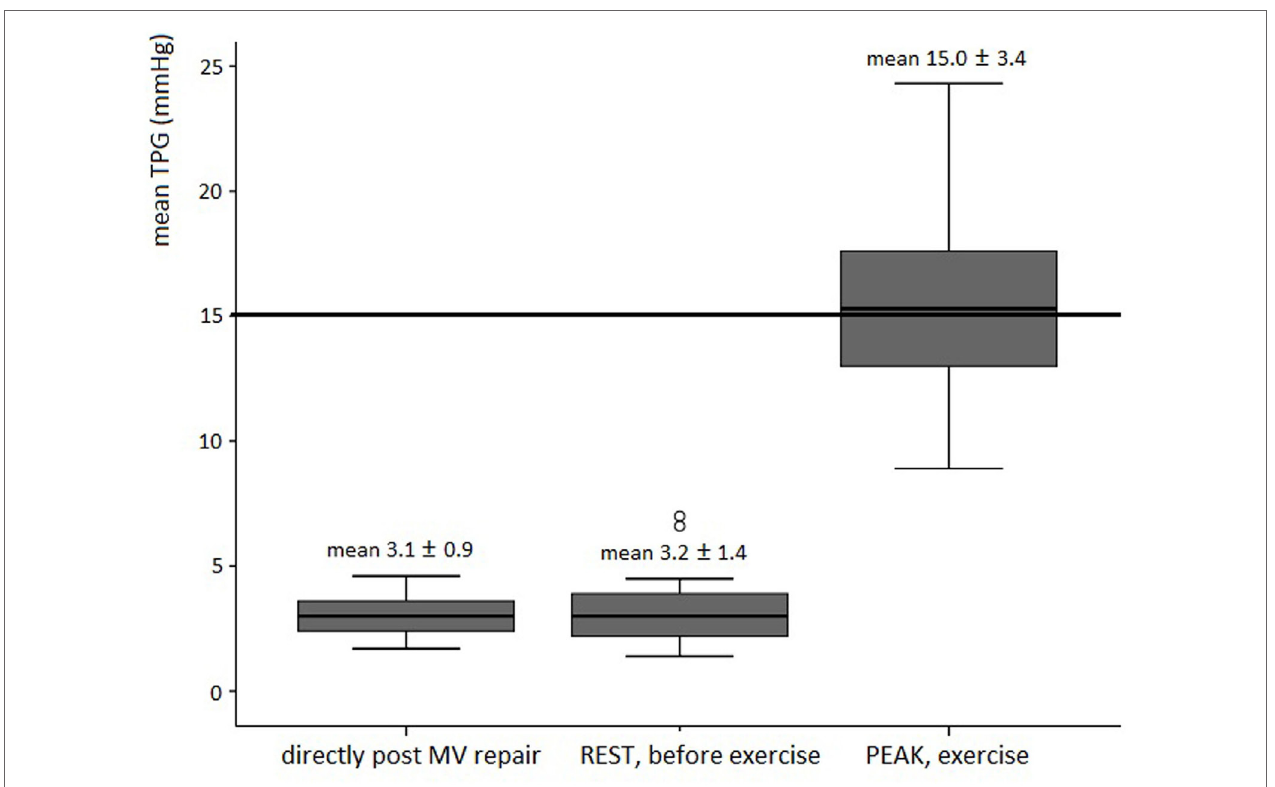
FigUre 1 | Boxplot figures showing the mean TPG directly post mitral valve repair, at rest (before stress echo) and peak exercise in asymptomatic patients post MV repair ( n = 25). The reference line (thick line) is the current recommendation for intervention in native valve disease (3, 4). Abbreviation: TPG, transmitral pressure gradient; MV, mitral